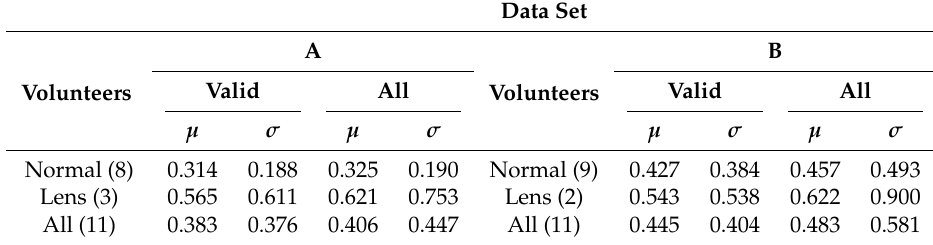
Figure 4. Gaze estimation of twenty-two calibration-like tests of eighteen points. Table 1. Statistical results of the accuracy using the data samples of the calibration-like tests of eighteen points. The number of volunteers is indicated in parenthesis; floating-point values represent angular distances in degrees. Data